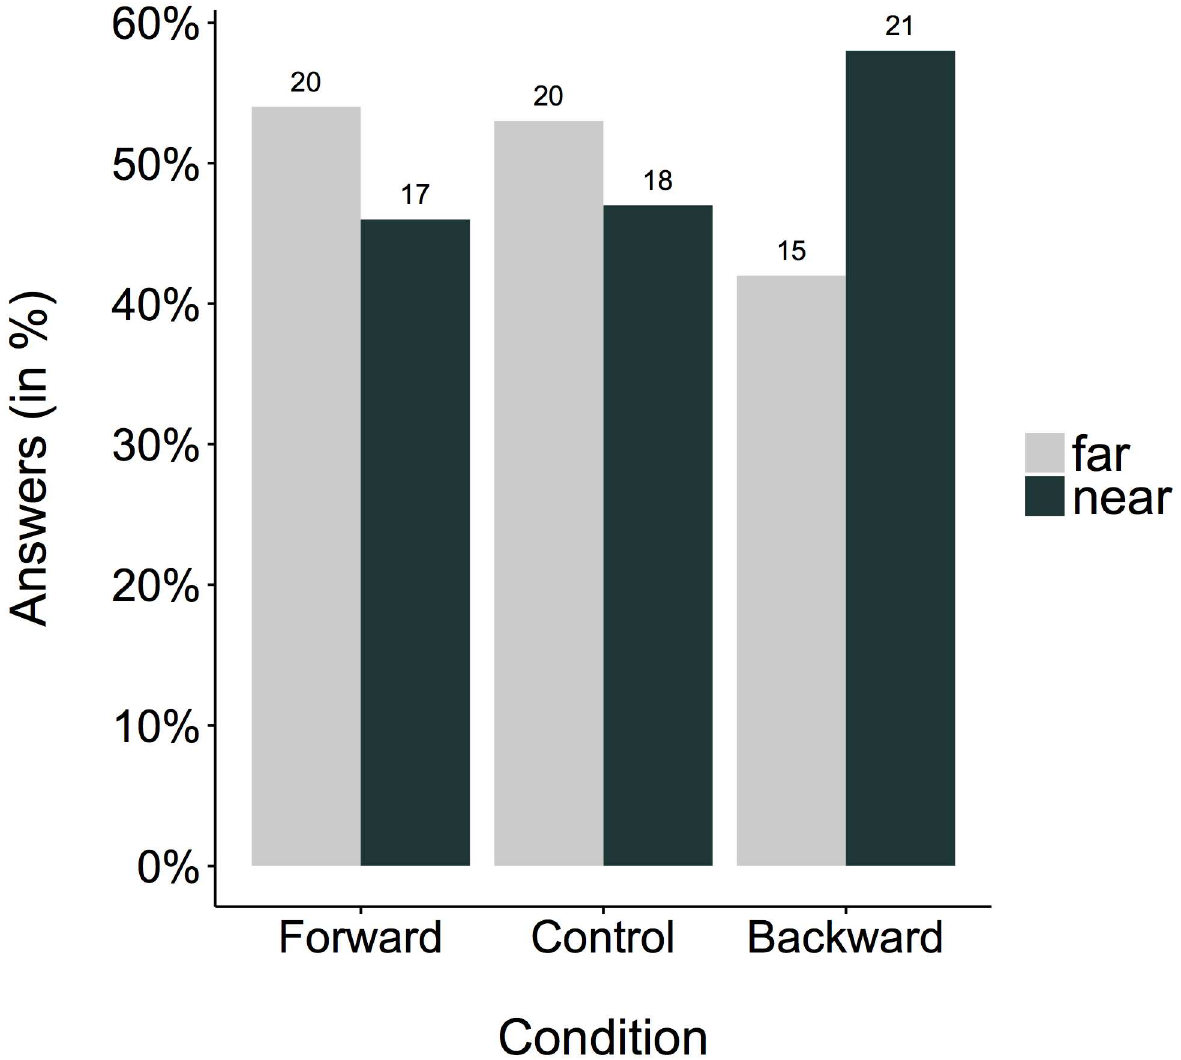
Fig 4. Percentage of “far” and “near” answers to the ambiguous spatial question plotted for the three different groups (i.e., walking conditions). The total number of answers is printed aboveeach bar.